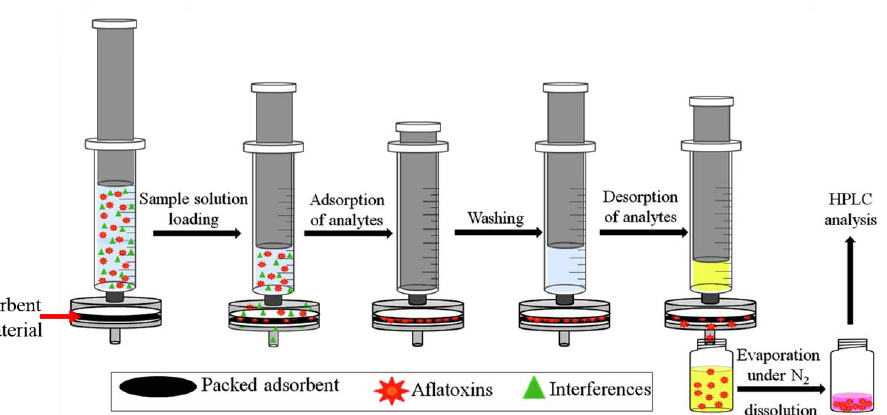
Figure 4. Schematic illustration of the in-syringe solid-phase extraction procedure using aflatoxins as target analytes (adapted and reprinted with permission from reference [57]).